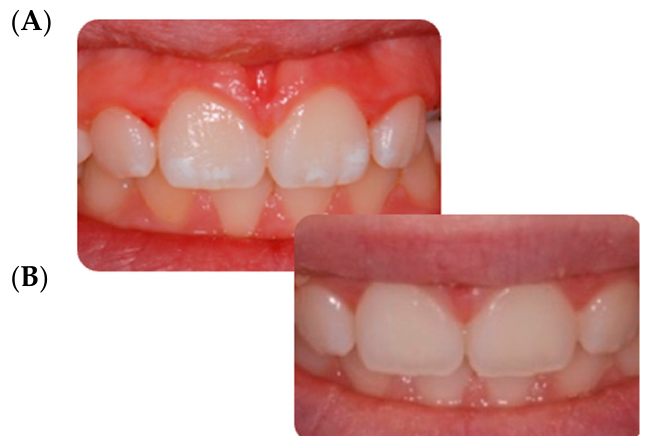
Figure 1. Mild MIH. ( A ) Opacities located on the central incisors’ buccal surfaces. ( B ) 24-month follow up.